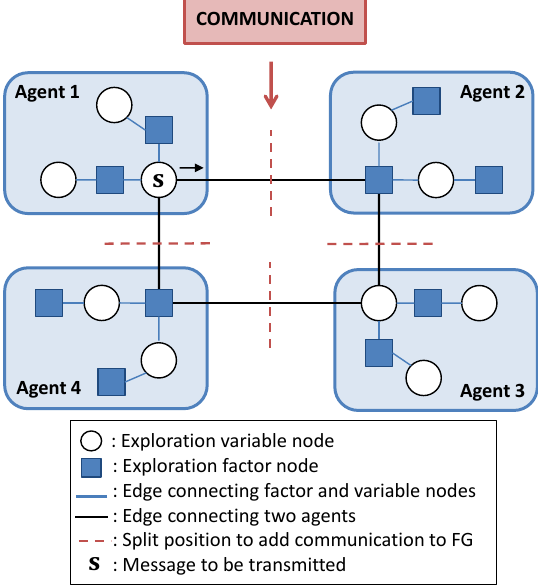
Figure 4. A schematic diagram of a joint FG for exploration and communication. The split of the FG w.r.t. spatially separated and distributed agents requires the inclusion of